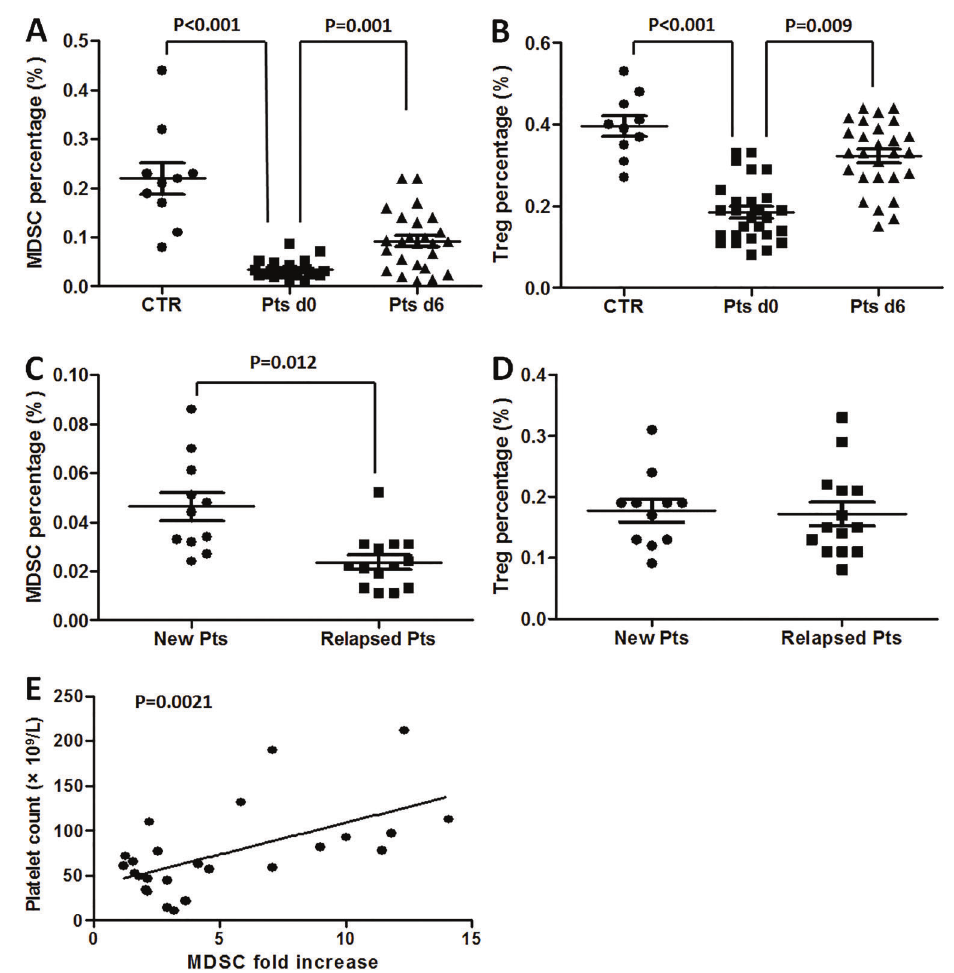
Figure 2. A , Blood levels of myeloid-derived suppressor cells (MDSCs), and B, regulatory T (Treg) cells were lower in active immune thrombocytopenia (ITP) patients (Pts) on day 0 (d0) compared to healthy controls (CTR). On day 6 (d6) after immunosuppressive treatment, both MDSCs and Treg cells partially recovered. C and D , Relapsed patients had signi fi cantly lower MDSC levels compared to newly diagnosed patients. However, Treg cell levels were similar between the two groups of patients (Student ’ s t -test). E , MDSC recovery was de fi ned as the percentage of MDSC on the 6th day after treatment divided by the percentage of MDSC before treat- ment (or the ‘‘ MDSC fold increase"). MDSC fold increase and the platelet level on the 11th day after treatment were correlated (linear regression